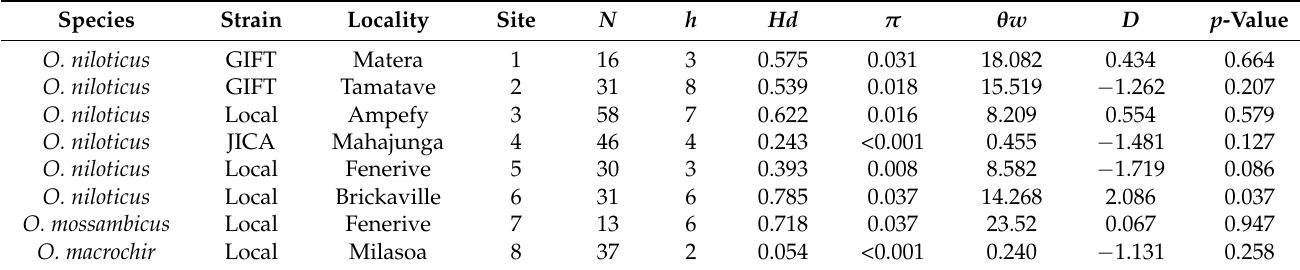
Table 2. Summary statistics of genetic diversity per MOTU. N , number of individuals; h , number of haplotypes; Hd , haplotypic diversity; π , nucleotide diversity; θ w , theta; Tajima’s D test including D value and significance of the test (* significant at 0.025 threshold, none of the tests were